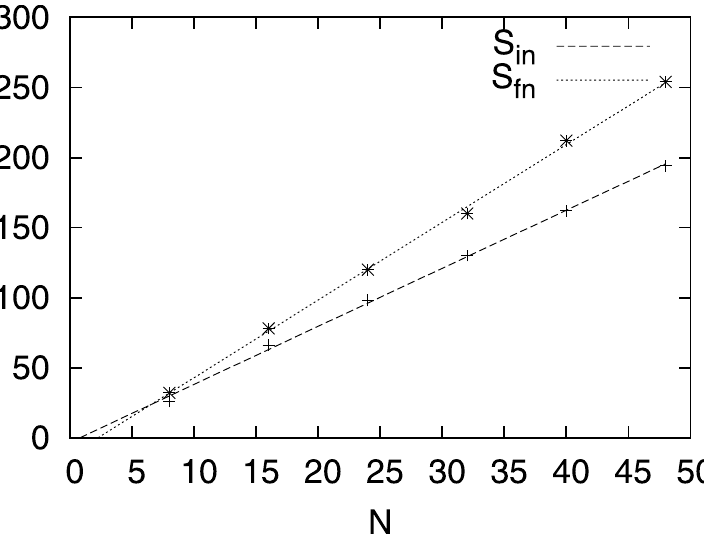
Fig 2. Sums of the degrees of the multiplex network grows linearly with the network size. S in is the sum of the degreesof the adjacency matrices of the starting networks and S fn the sum of the degreesof the adjacency matrices of the finally evolvedmultiplexnetworks of the evolutionprocess.